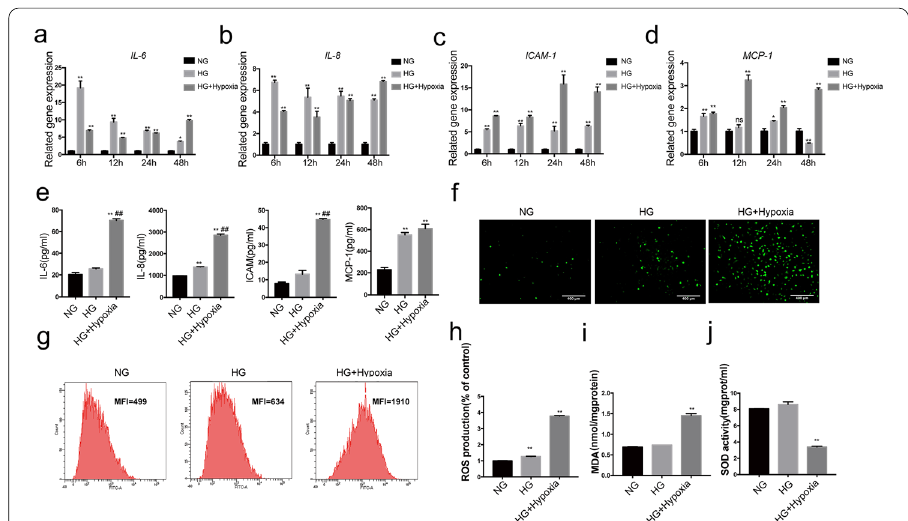
Fig. 2 Combined stimulation with high glucose and hypoxia increases inflammation and oxidative stress in HUVECs. Cells were treated with high glucose (25 mM) or with combined exposure to high glucose and hypoxia. Glucose alone or combined stimulation with both factors significantly increased mRNA expression of IL-6 ( a ), IL-8 ( b ), ICAM-1 ( c ), MCP-1 ( d ) after 6, 12, 24, 48 h, and similarly increased protein secretion at 48 h ( e ), increased cell ROS production ( f–h ), increased MDA level (i), and reduced SOD activity ( j ) for 48 h compared with controls. n 3; p < 0.05 and ** p < 0.01 vs. control. # p < 0.05 vs. glucose. HG, high glucose; = HG Hypoxia, combined stimulus with high-glucose and hypoxia; NG, +